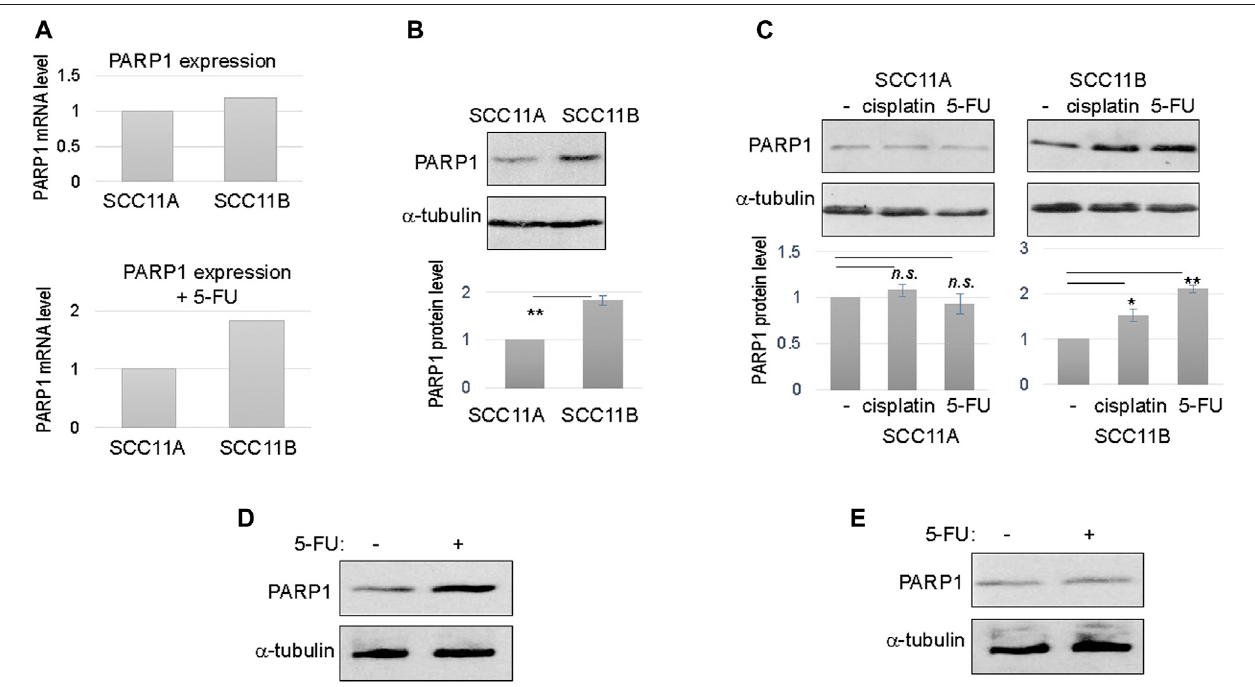
FIGURE 1 | Upregulation of PARP1 in recurrent oral cancer cells. (A) The levels of PARP1 mRNA in SCC11A and SCC11B cells, without DNA damage (upper panel) , or with 5-FU treatment (lower panel) . (B) SCC11A and SCC11B cells were analyzed by immunoblotting for the protein levels of PARP1 and α -tubulin (loading control). The band intensity was quanti fi ed, and the PARP1 to α -tubulin ratio was shown in the lower panel. The relative PARP1 protein level in SCC11B was normalized to that in SCC11A. The average of three independent experiments was shown, with statistical analysis (** p < 0.01). (C) SCC11A and SCC11B cells were treated with cisplatin (10 μ M) or 5-FU (10 μ M), as indicated, for 1 day. The treated and untreated cells were analyzed by immunoblotting for PARP1 and α -tubulin. The band intensity was quanti fi ed, and the PARP1 to α -tubulin ratio was shown in the lower panel. The relative PARP1 protein level in drug treated cells was normalized to that in untreatedcells.Theaverageofthreeindependentexperimentswasshown,withstatisticalanalysis(* p < 0.05,n.s.notsigni fi cant). (D) SCC10Bcellsweretreatedwithor without 5-FU (10 μ M), for 1 day. The cells were then analyzed by immunoblotting for PARP1 and α -tubulin. (E) The oral mucosal epithelial cells were treated with or without 5-FU (10 μ M), for 1 day. The cells were then analyzed by immunoblotting for PARP1 and α -tubulin.